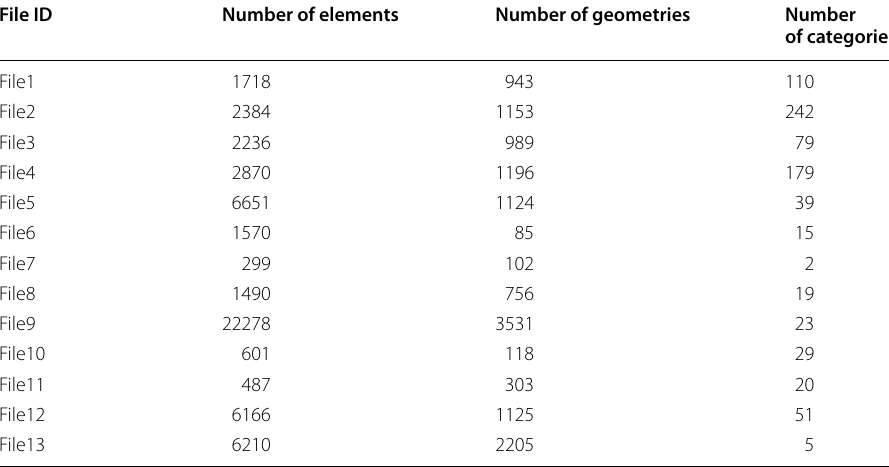
Table 4 Data (in Files) and quantity